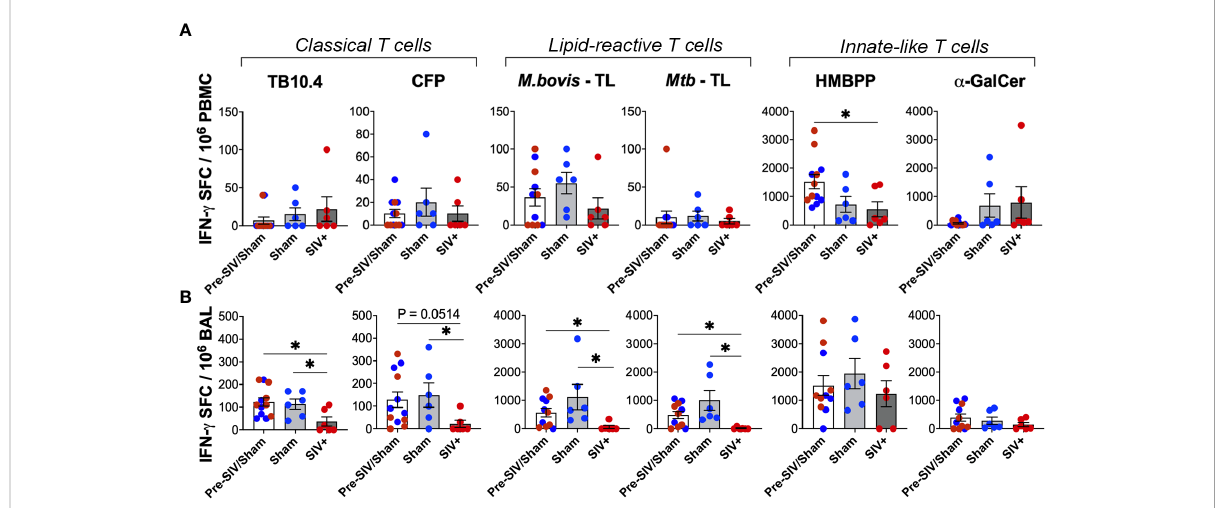
FIGURE 8 Loss of peptide- and lipid-reactive IFN- g responses in BAL fl uid of macaques following SIV infection. Quanti fi cation of IFN- g producing cells expressed as SFU/million cells, following stimulation with TB10.4 peptide pool, M.bovis CFP, M.bovis and Mtb TL fractions, HMBPP, and a - GalCer in freshly isolated (A) PBMCs, and (B) BAL lymphocytes. 1wk pre-SIV/sham inoculation (white bars), and 6-8 weeks post SIV/sham (grey bars) show individual macaques inoculated with either sham (blue circles) or SIV (red circles). Unpaired t test was used to compute differences between groups and with respect to pre-SIV/sham baseline. Asterisks indicate signi fi cant differences between time points (*p <